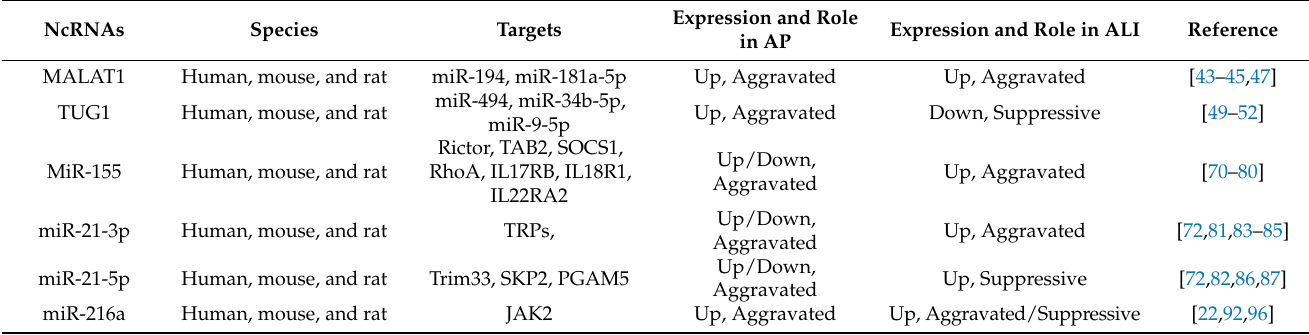
Table 1. Exosome-ncRNAs in AP and